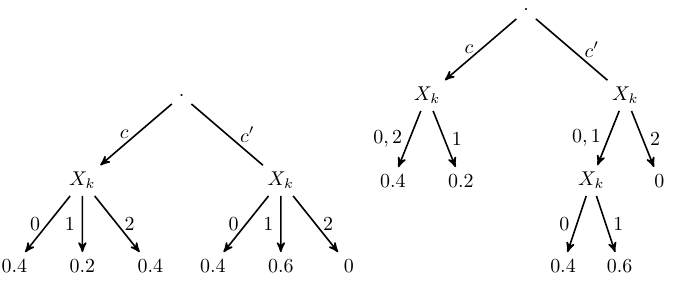
Figure 5. Binary tree